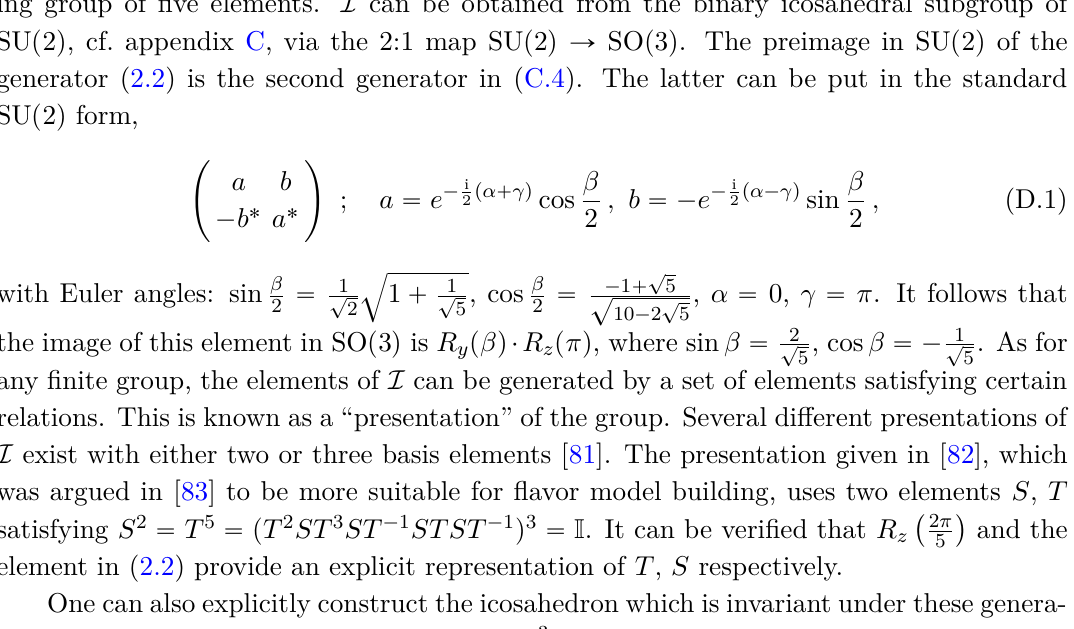
Figure 2. The icosahedron. Only eight of the twelve vertices are depicted: the top and bottom vertices ( V ), three of the upper pentagon vertices ( U 1 , 2 ( L ). The distance L from each of the vertices of the upper and lower pentagons to the z -axis, 1 , 2 , 5 is also equal to the vertical distance between the upper and lower